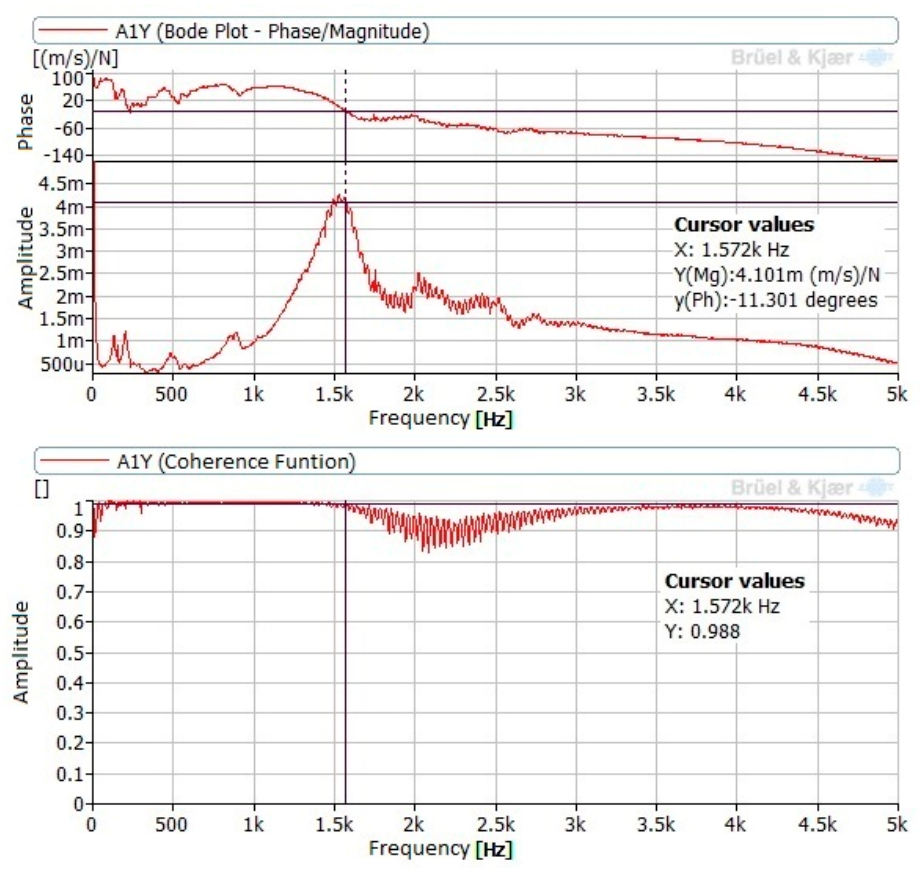
Figure 6. FRF obtained at P1 with impact at I2.